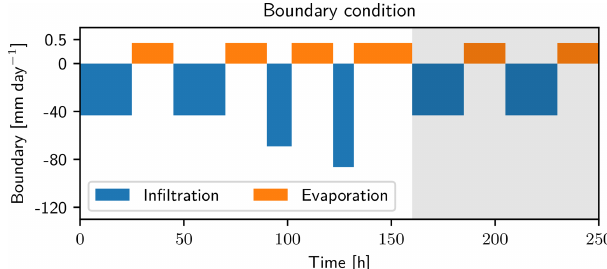
Figure 3. Upper boundary condition for the data assimilation case. Four rain events (blue) followed by a dry period (orange) are used for the test of the data assimilation run. After this run, two additional rain events and dry periods are used in a free run to test the assimi- lation results (grey background). The intensity and duration of these events is set to be equal to the first events of the data assimilation run. Note the different axes for infiltration and evaporation.